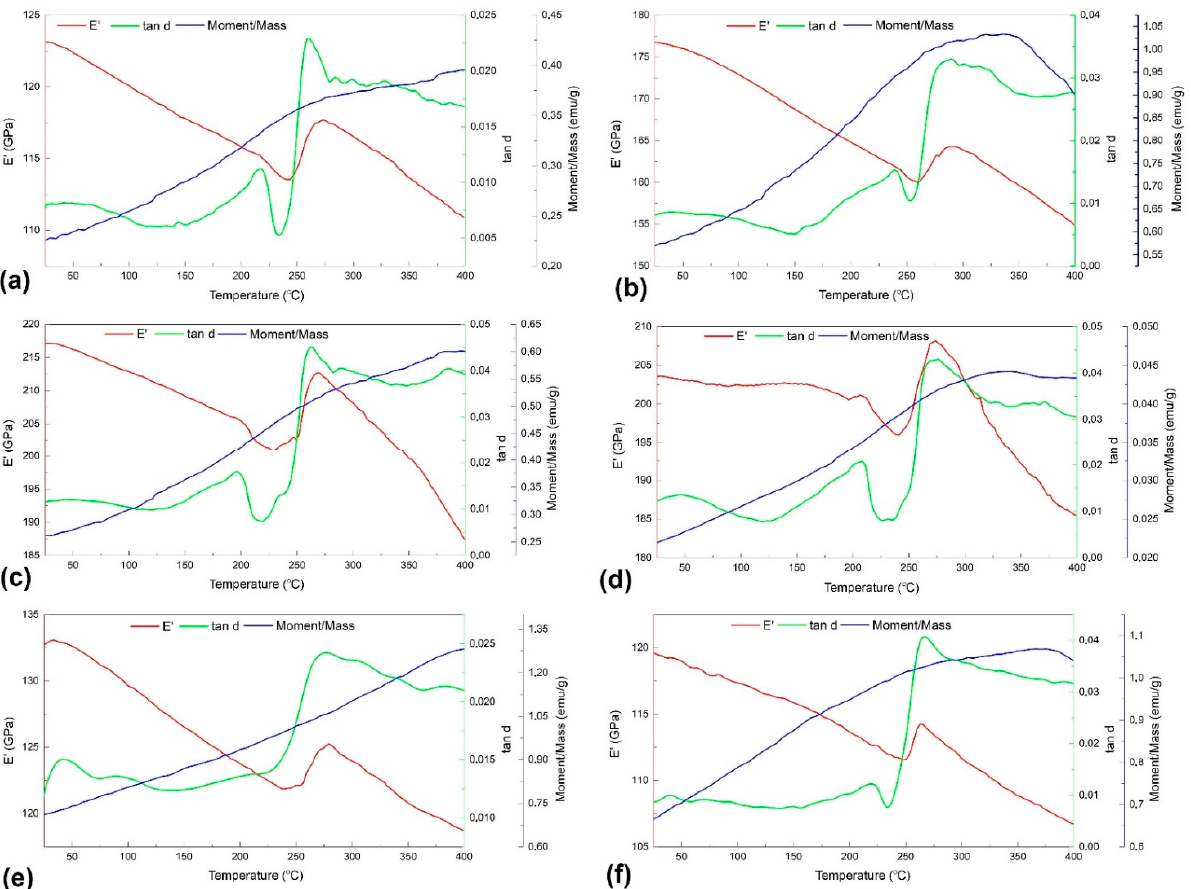
Figure 1. Thermograms recorded during heating, illustrating the variations with temperature of E ′ , tan δ and M for an applied magnetic field of 20 Oe, in the case six of specimens: ( a ) 0_MA_700 ; ( b ) 0_MA_1100 ; ( c ) 20_MA_700 ; ( d ) 20_MA_1100 ; ( e ) 40_MA_700 ; ( f ) 40_MA_1100 .